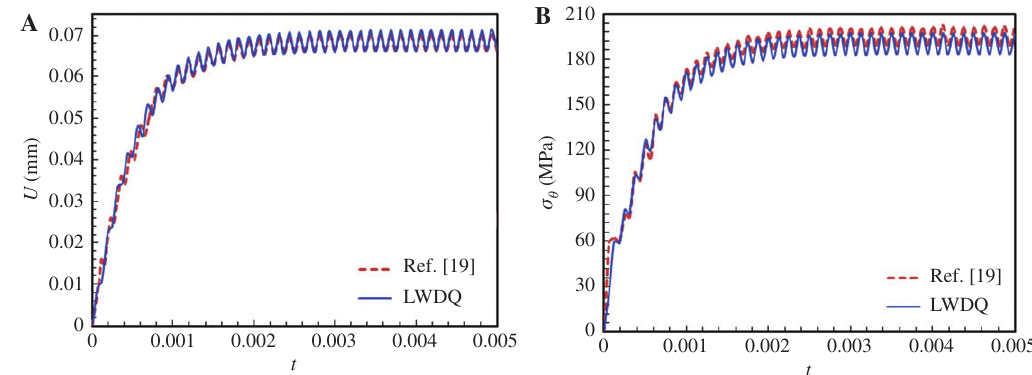
Figure 2 Comparison of time histories of radial displacement and tangential stress at the inner surface of the FG shell with those obtained by Shariyat et al. [19] .